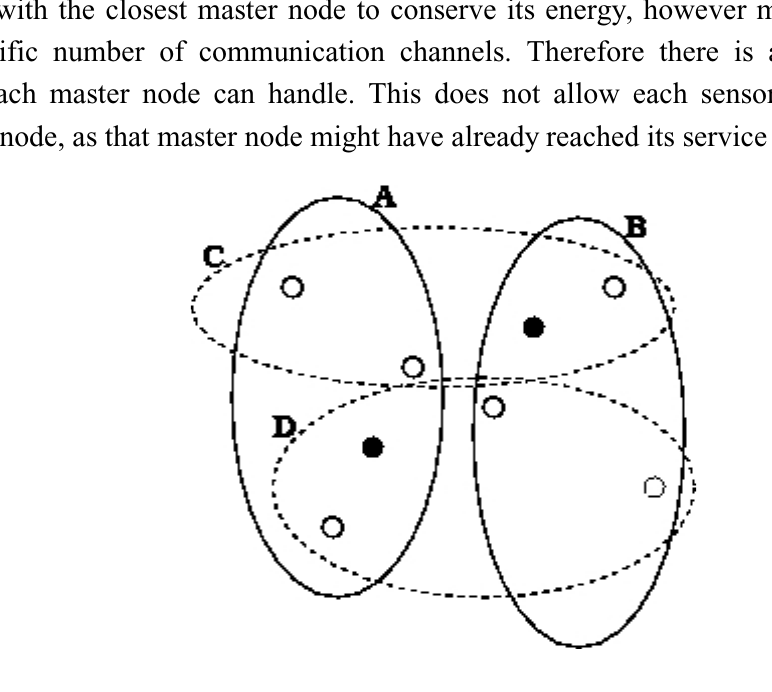
Figure 1. Partitioning the nodes into clusters A and B leads to a solution dissipating less communication energy compared to clusters C and